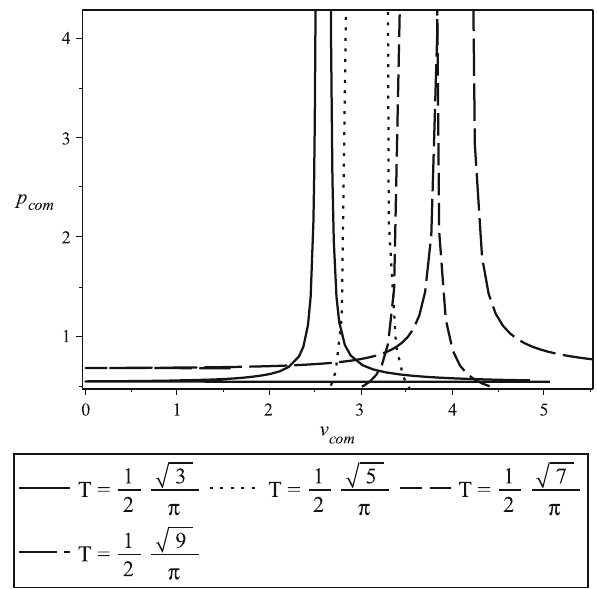
Fig. 13 A P – V diagram between holographic complexity and pres- sure,showingatotallydifferentbehaviorfromthethermodynamic P – V